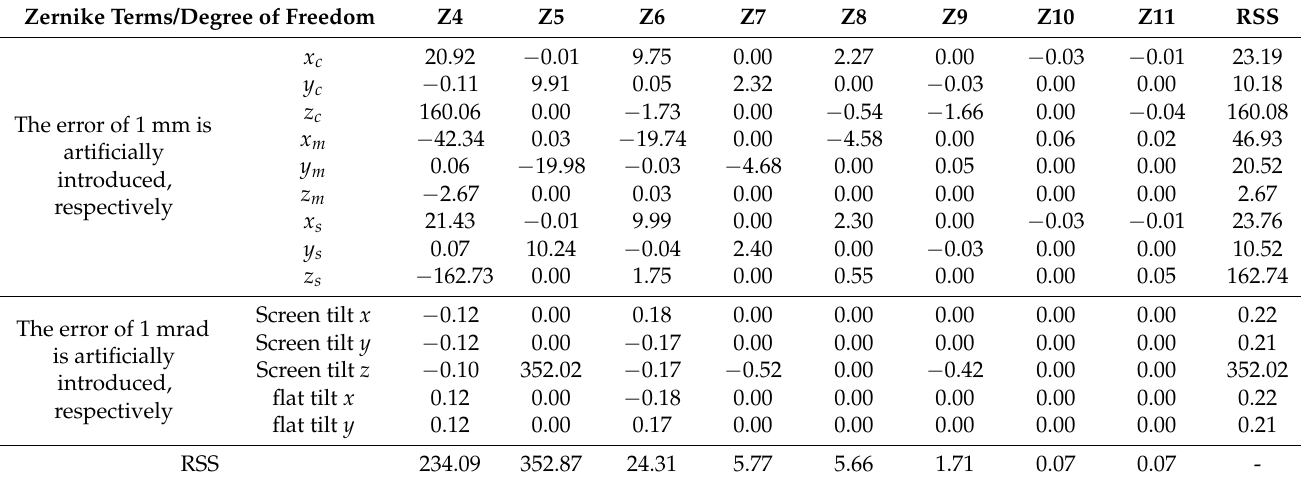
Table 1. The difference in Zernike coefficient caused by the disturbance of each degree of freedom. Unit: nm. Zernike Terms/Degree of Freedom Z4